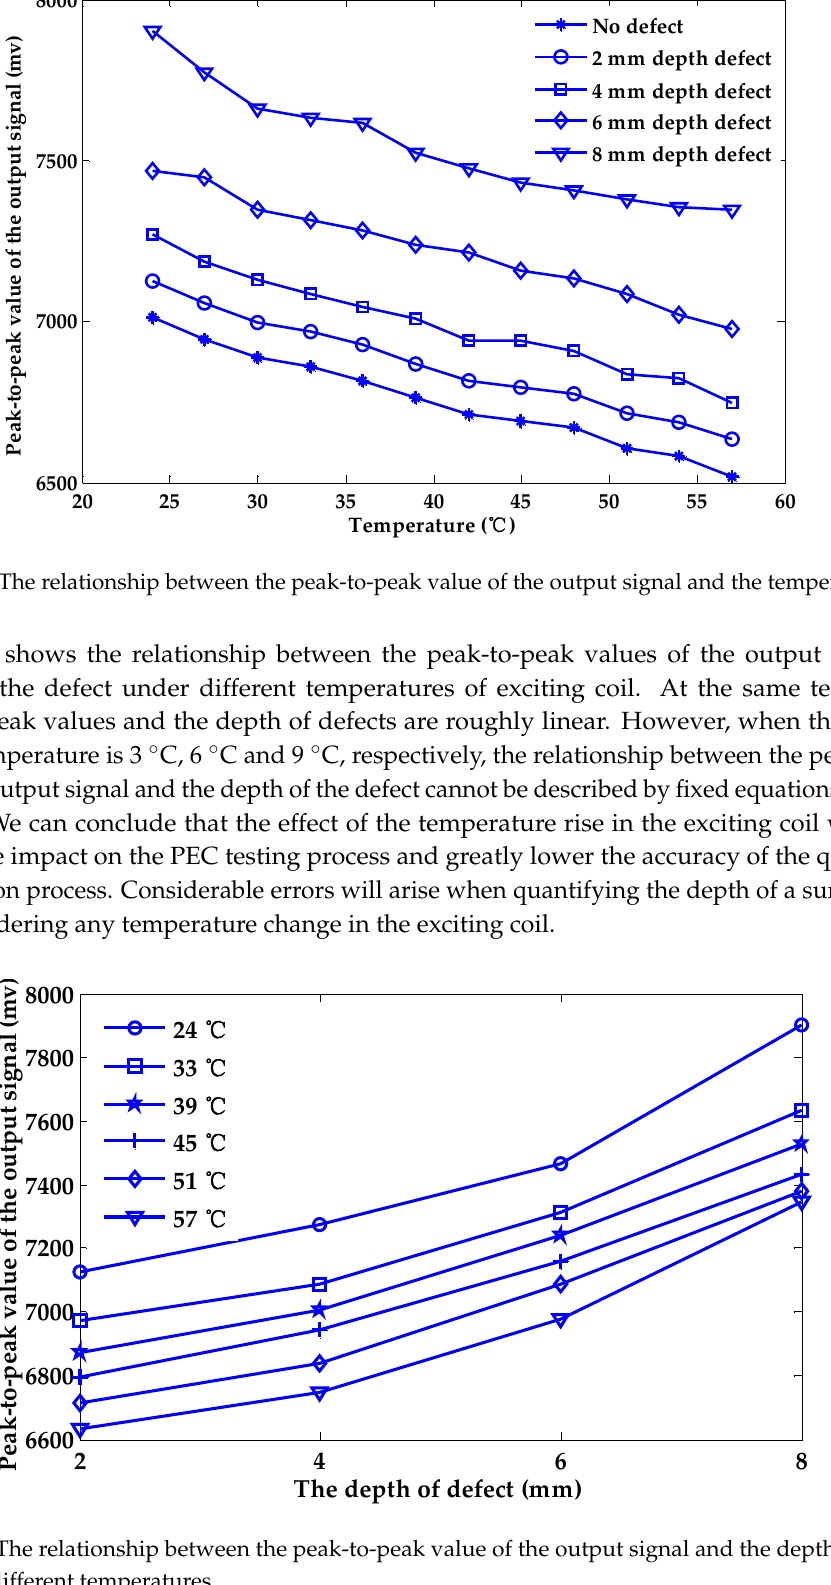
Figure 4. The effect of temperature rises in the exciting coil on the testing signal.